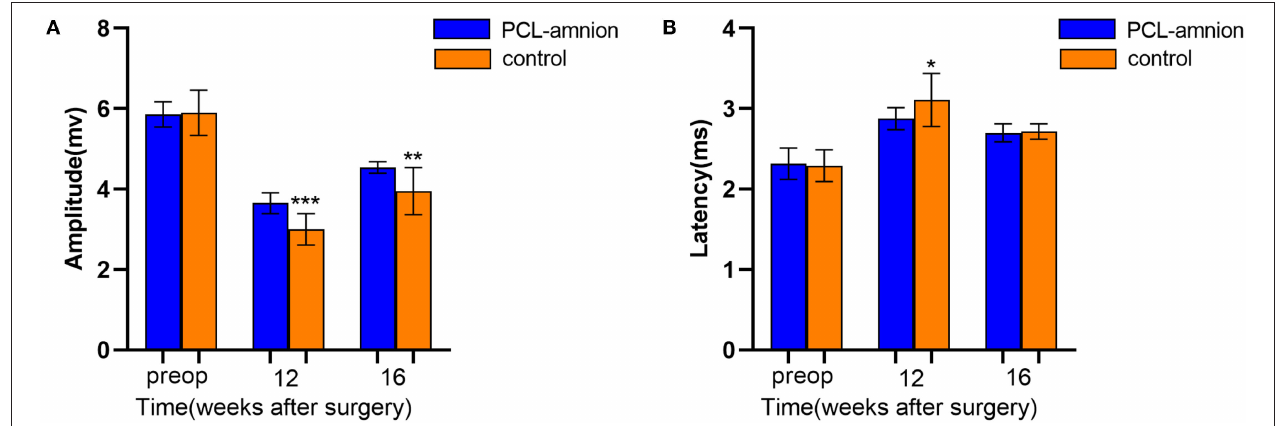
FIGURE 6 | Electrophysiology testing. The motor amplitude and latency were analyzed to assess the functional recovery of the sciatic nerve. (A) The PCL-amnion nanofibrous membrane group shows significantly greater amplitude at 12 and 16 weeks ( P < 0.05). *** P < 0.001 compared to the PCL-amnion group at 12 weeks. *** P < 0.01 compared to the PCL-amnion group at 16 weeks. (B) The PCL-amnion nanofibrous membrane group shows significantly greater latency at 12 weeks ( P < 0.05); however, the latencies between two groups were not significantly different at 16 weeks ( P > 0.05). * P < 0.05 compared to the PCL-amnion group at 12 weeks.